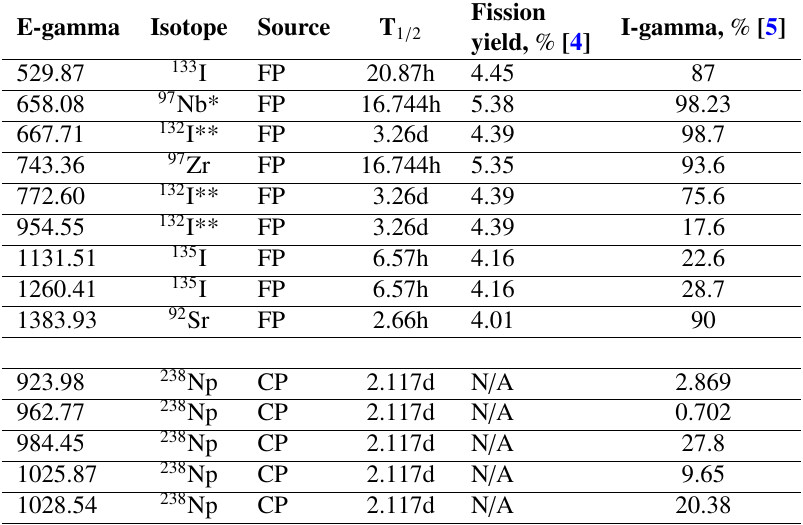
Figure 7. Np-237 fission-to-capture ratio for 0.66 GeV proton beam dependence on sample location - for samples located on top of QUINTA’s core (TS2, TS4) and in the left side window (LSW)